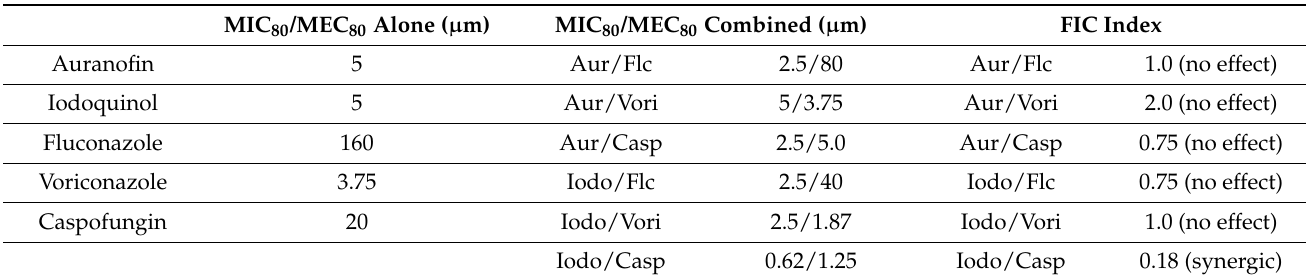
Table 3. Antifungal activity of auranofin, iodoquinol, fluconazole, voriconazole and caspofungin—Alone and in combinations according to Fractional Inhibitory Concentration Index—against S. aurantiacum CBS 136046. MIC values were used to analyze the interaction between auranofin and iodoquinol with azoles (fluconazole and voriconazole), whereas MEC values were used to assess the interaction between auranofin and iodoquinol with caspofungin.